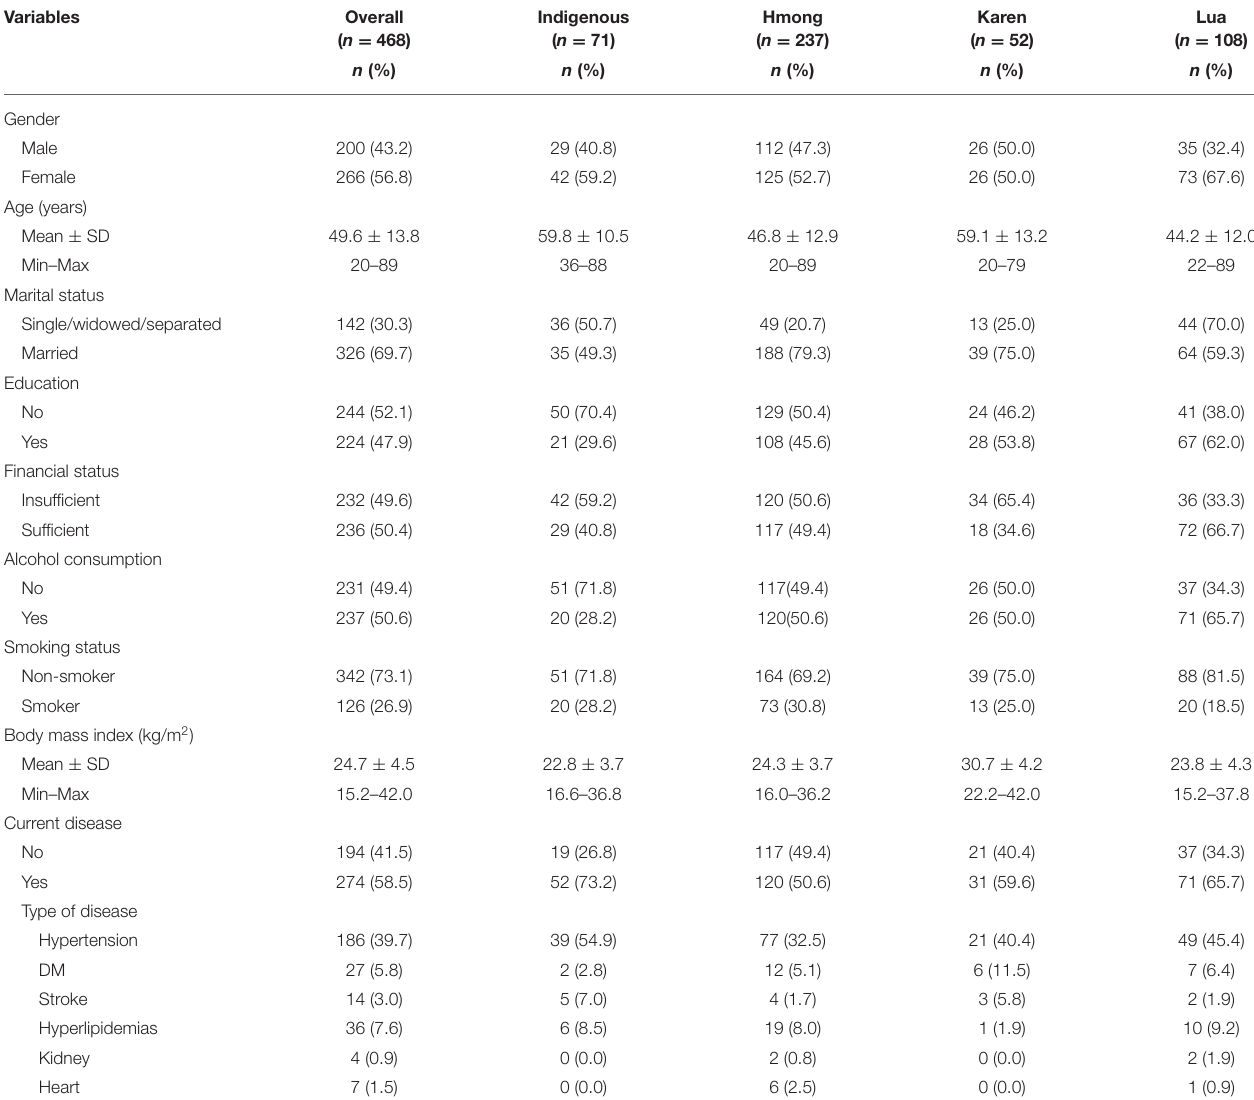
TABLE 1 | Sociodemographic of participants categorized based on minority groups.